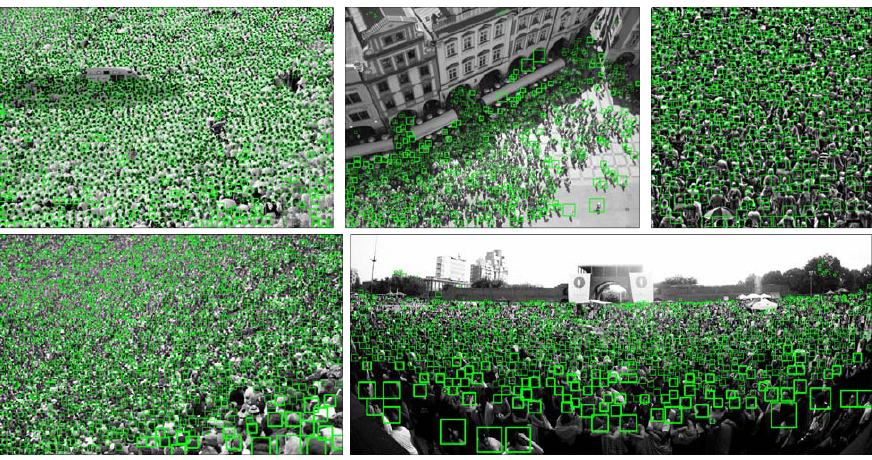
Figure 5. Qualitative results on the UCF_CC_50.